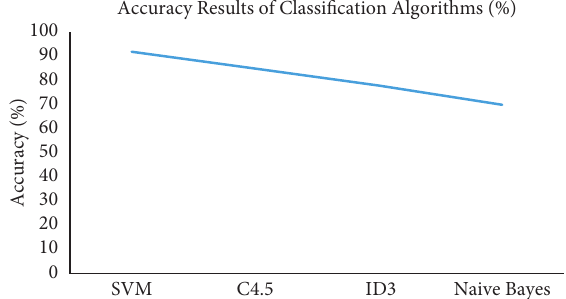
Figure 2: Graphical representation of accuracy results of classi- fication algorithms (%).